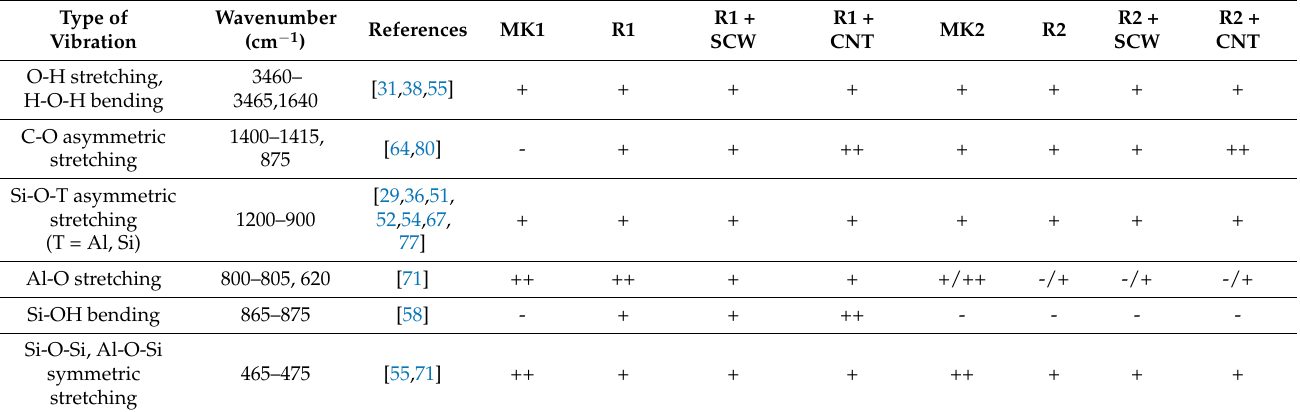
Table 5. Specifications of vibration band for R1 and R2 based